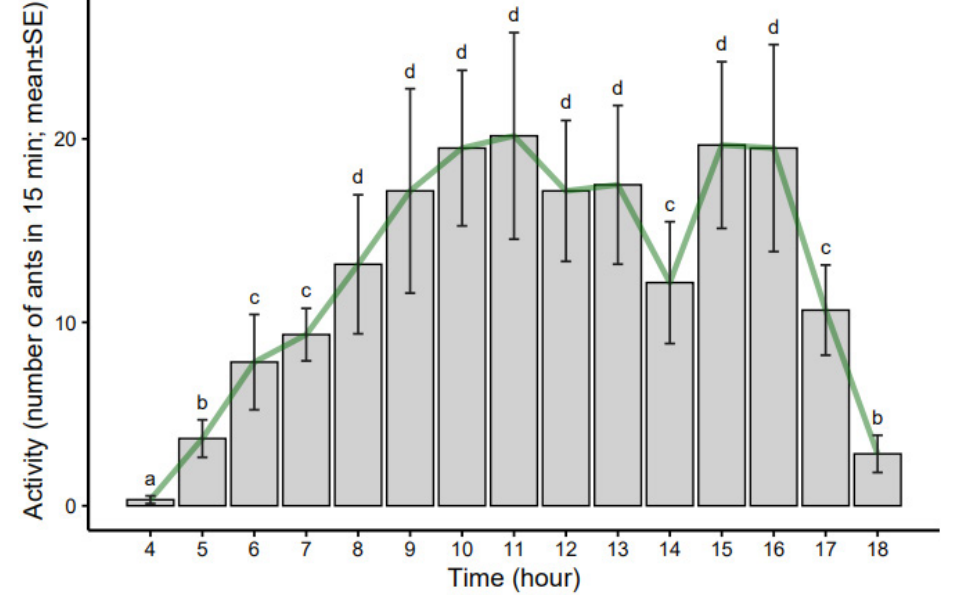
Fig 2 . Mean number of foragers in activity every 15 minutes between 4:00 a.m. and 6:00 p.m. of six colonies of Cephalotes borgmeieri . The letters were determined by contrast analysis and indicate (a) zero activity, (b) low activity, (c) medium activity and (d) high activity. (Confidence intervals indicate the standard error of the mean found for the six colonies evaluated) (χ 2 = 0.114; p = 0.736). The variable that best fits the activity of C. borgmeieri is the temperature (R 2 = 0.376), followed p = <0.001), air humidity (χ 2 = 56.804; p = 0.001), and light by air humidity (R 2 = -0.158) and later by luminosity intensity (χ 2 = 26.890; p = <0.001) but not wind speed (R 2 = 0.099).